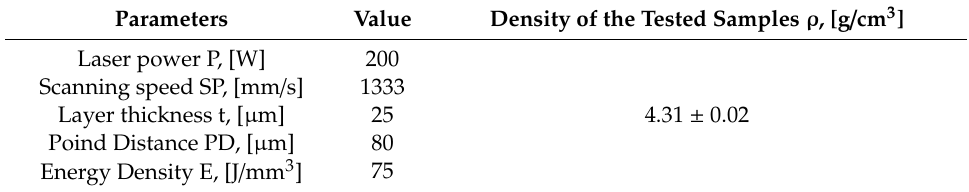
Table 2. Process parameters and obtained density value of test samples.